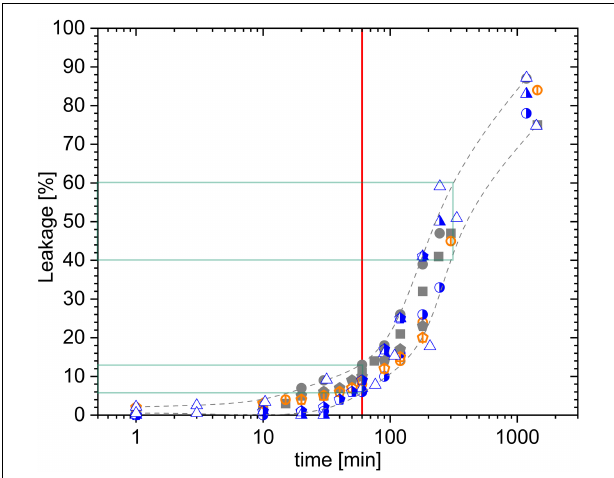
FIGURE 2 | Error analysis for different “peptide-into-lipid” mixing protocols. Leakage kinetics data for 25 µ M PSD-C14 acting on liposomes of 30 µ M POPC (=lipid) as a function of incubation time. Gray solid symbols represent mixing sequences with 30 µ M lipid + PSD-C14, open orange symbols with vertical bar denote the sequence of 15 µ M lipid + PSD-C14 + 15 µ M lipid (so far, all liposomes calcein loaded), and half-blue symbols represent the sequence of 15 µ M lipid without calcein + PSD-C14 + 15 µ M lipid calcein loaded. Different symbol types with the same color/style stand for individual series of experiments. Grid lines point to the 1 h standard incubation time (red) and typical L errors after 1 and 5 h